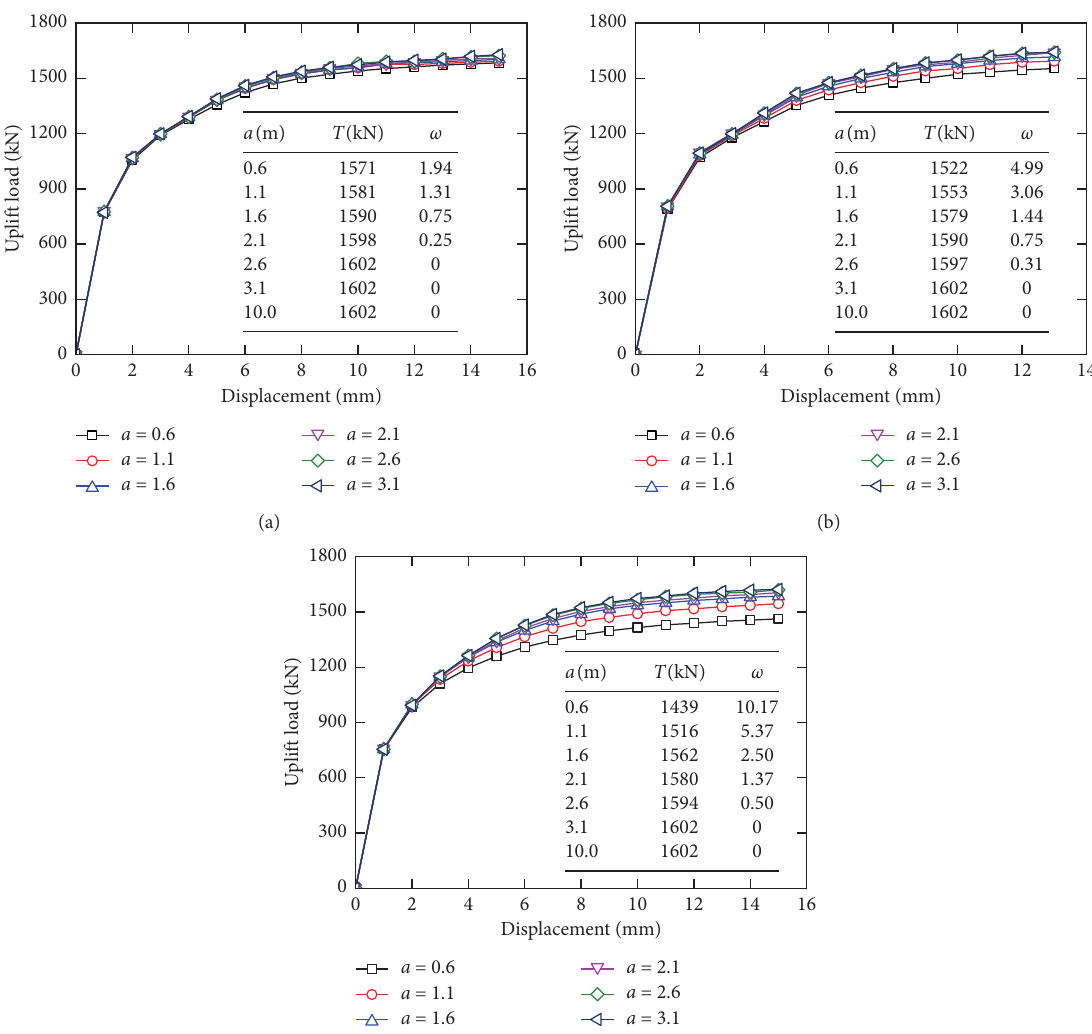
Figure 10: Simulation results of slope-foundation models with h of 3m and β of (a) 15 ° , (b) 30 ° , and (c) 45 °